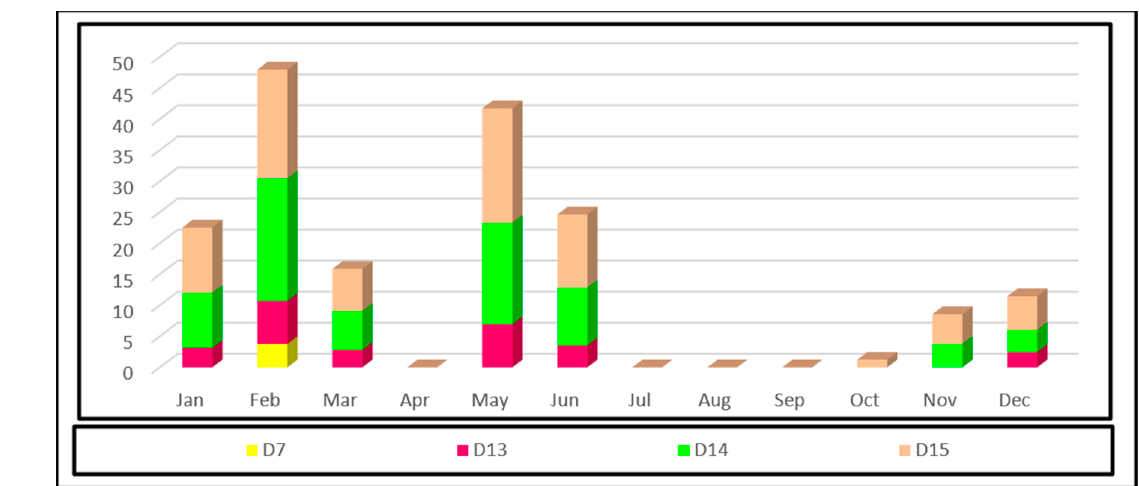
Figure 15. Monthly unmet demand (MCM) of lining four sections.